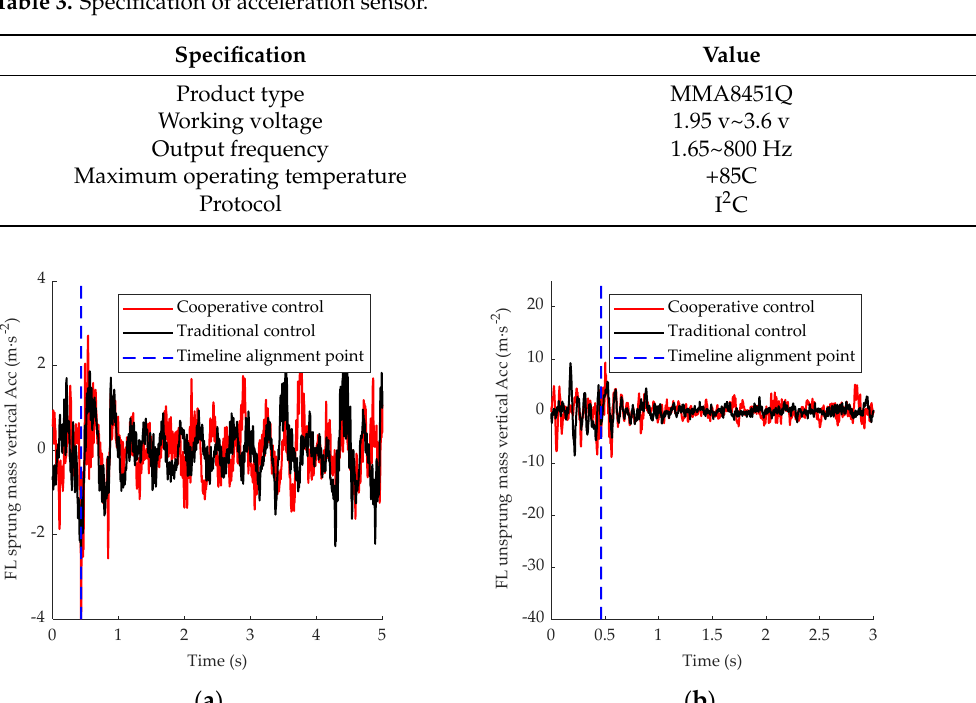
Figure 10. Comparison of cooperative control and traditional control under straight condition. ( a ) Front-left sprung mass vertical acceleration. ( b ) Front-left unsprung mass vertical acceleration. The sprung mass acceleration and unsprung mass acceleration of cooperative and traditional control under bump working condition are illustrated in Figure 11.